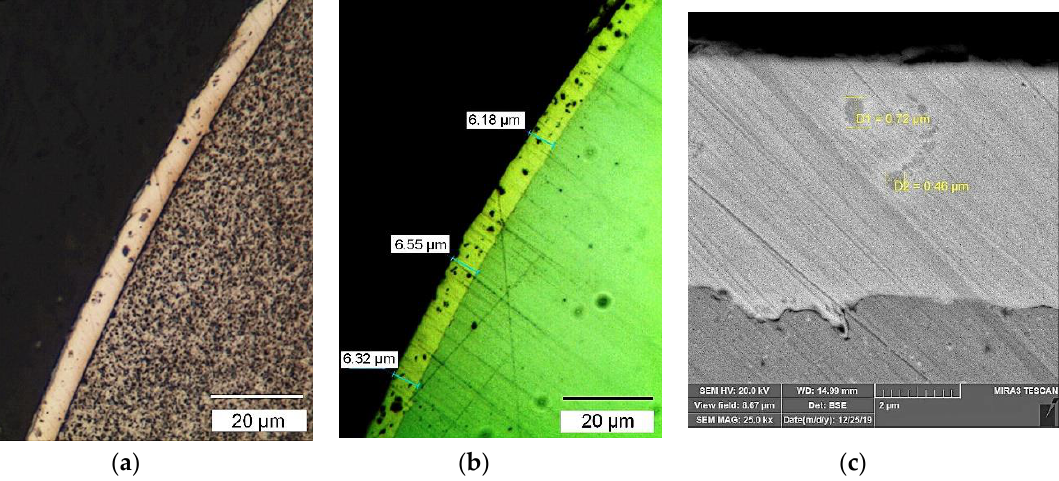
Figure 7. The microstructure of composite coatings: optical ( a , b ) and SEM images ( c ) of the microstructure of composite coatings on the Union X96 wire: ( a ) Ni-LaF 3 coating; ( b ) Ni-LaB 6 coating; ( c ) LaF 3 particles in an Ni-matrix.